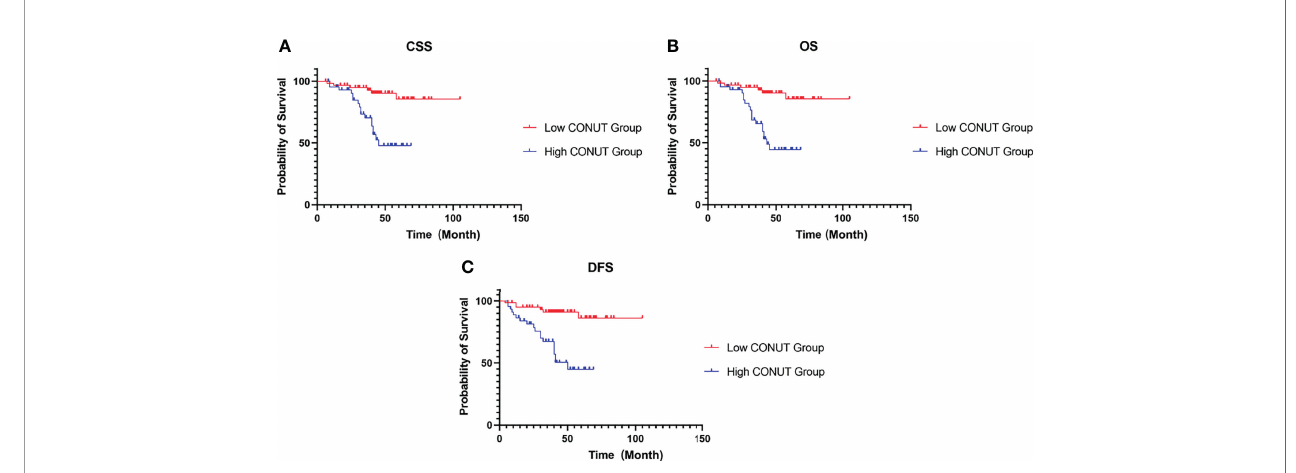
FIGURE 2 | Kaplan – Meier survival curves for HIV-related RCC patients treated with surgery. Survival curves set at cutoff value 3 for CSS (A) , OS (B) and DFS (C) . RCC, renal cell carcinoma; CSS, cancer-speci fi c survival; OS, overall survival; DFS, disease-free survival; CONUT, controlling nutritional